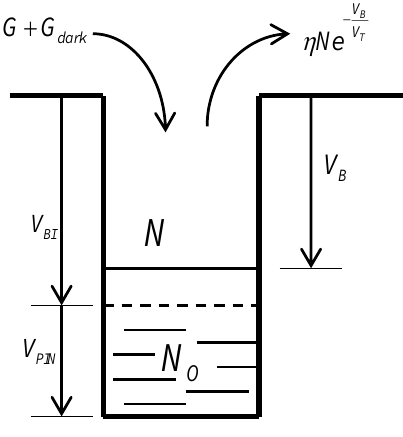
Figure 2. Free electron movements inside a buried photodiode.